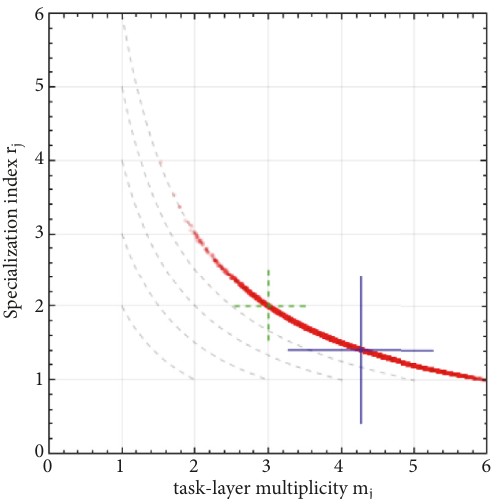
Figure 4: The red dots denote individual specialization indices 𝑟 a function of individual task-layer multiplicities 𝑚 in a 6-layer random simplex point-picked population of 10,000 individuals. The blue cross is the specialization index R for this population; the green-dashed cross is for a more specialized “nur- ture/adventure” population. The dashed lines follow 𝑟 of 2 through 6 layers, successively outward from the